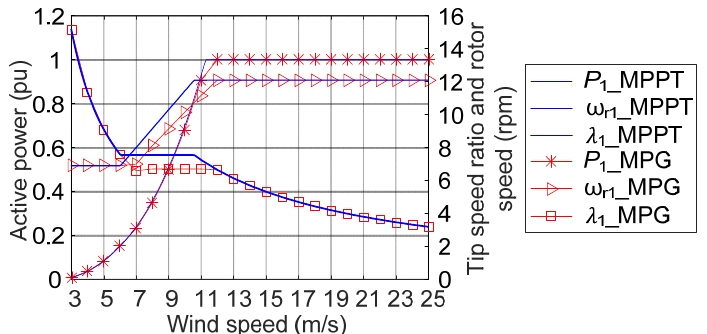
Figure 7. Comparison of the tip speed ratio, rotor speed and active power of WT 1 between the MPPT method and the Maximum Power Generation (MPG) method at 270° wind direction.